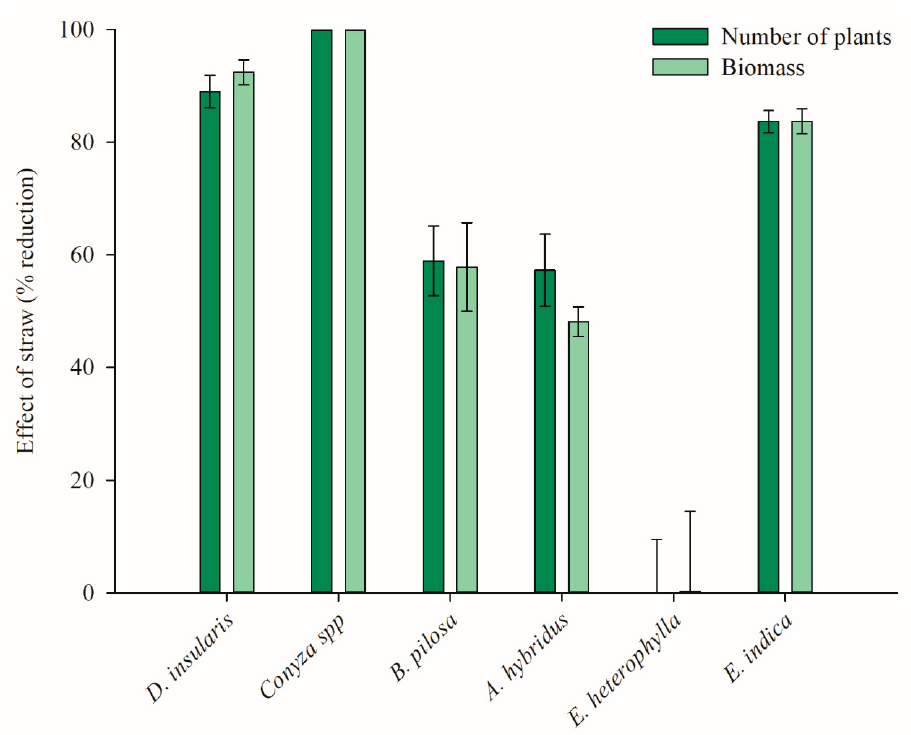
Figure 2. Effect of corn straw on weed emergence and biomass accumulation.